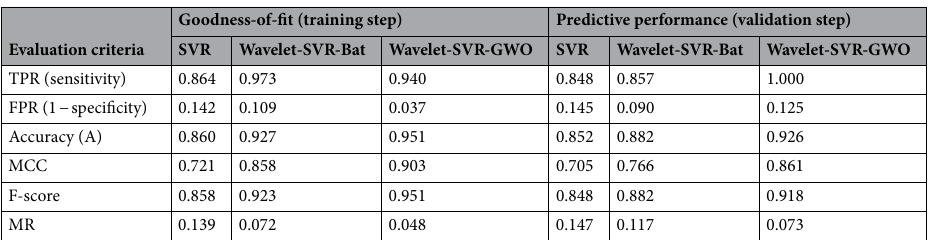
Table 2. Goodness-of-fit and predictive performance of models based on cutoff-dependent criteria. TPR true positive rate, FPR false positive rate, MCC Matthews correlation coefficient, MR misclassification rate.